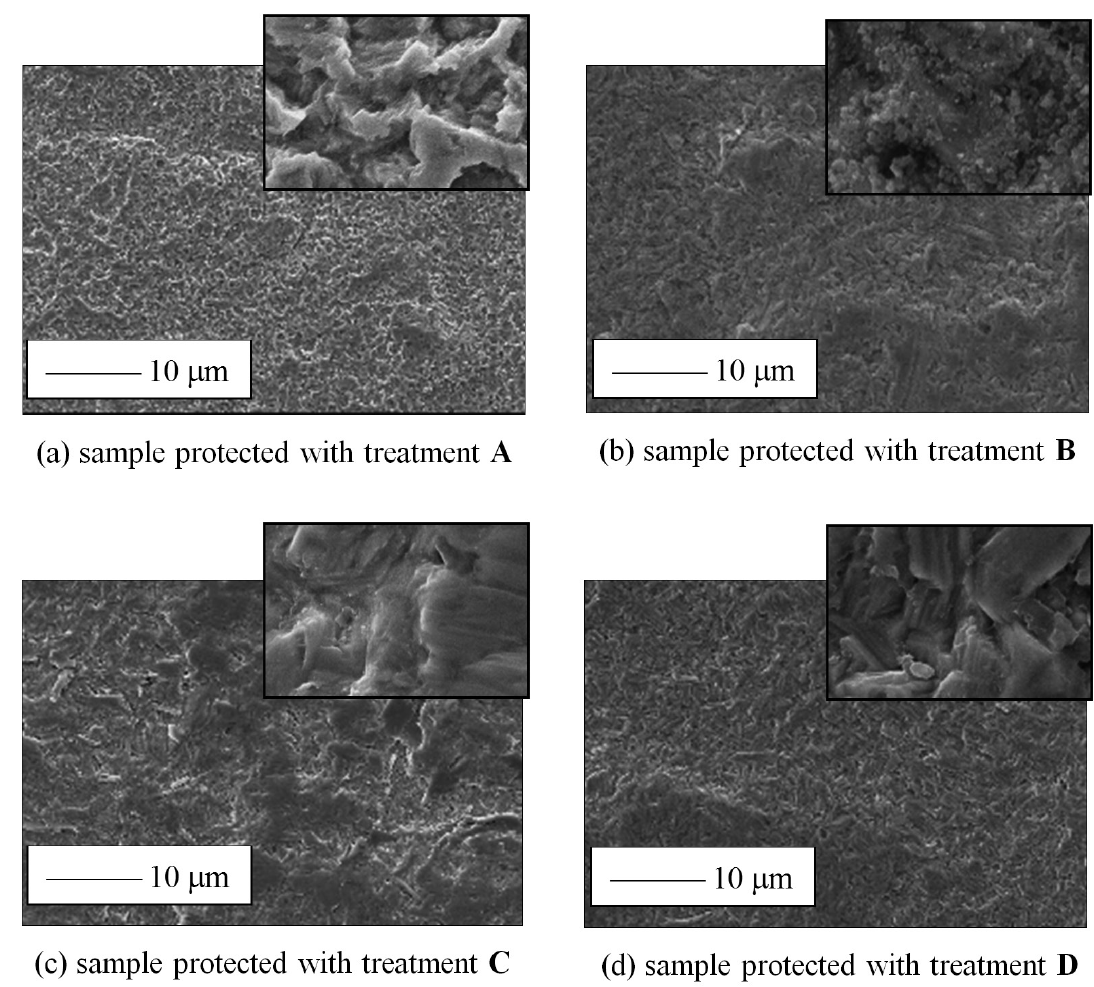
Figure 1. SEM micrographs of the electrogalvanised steel samples covered with different conversion treatments.